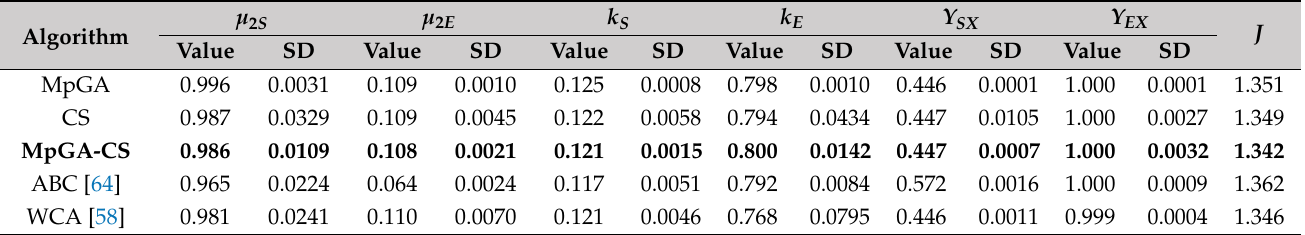
Table 5. Model parameter estimates of S. cerevisiae FP model (Equation